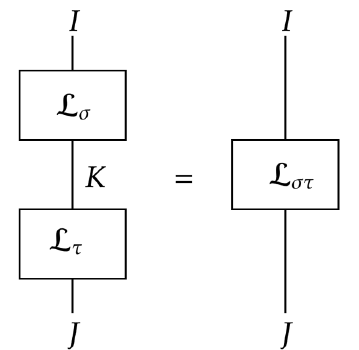
Figure 3 . The diagrammatic interpretation of the multiplication of linear operators L σ and L τ . In terms of the tensor components of these operators, ( L σ ) i 1 ,...,i n the sum over repeated k indices is